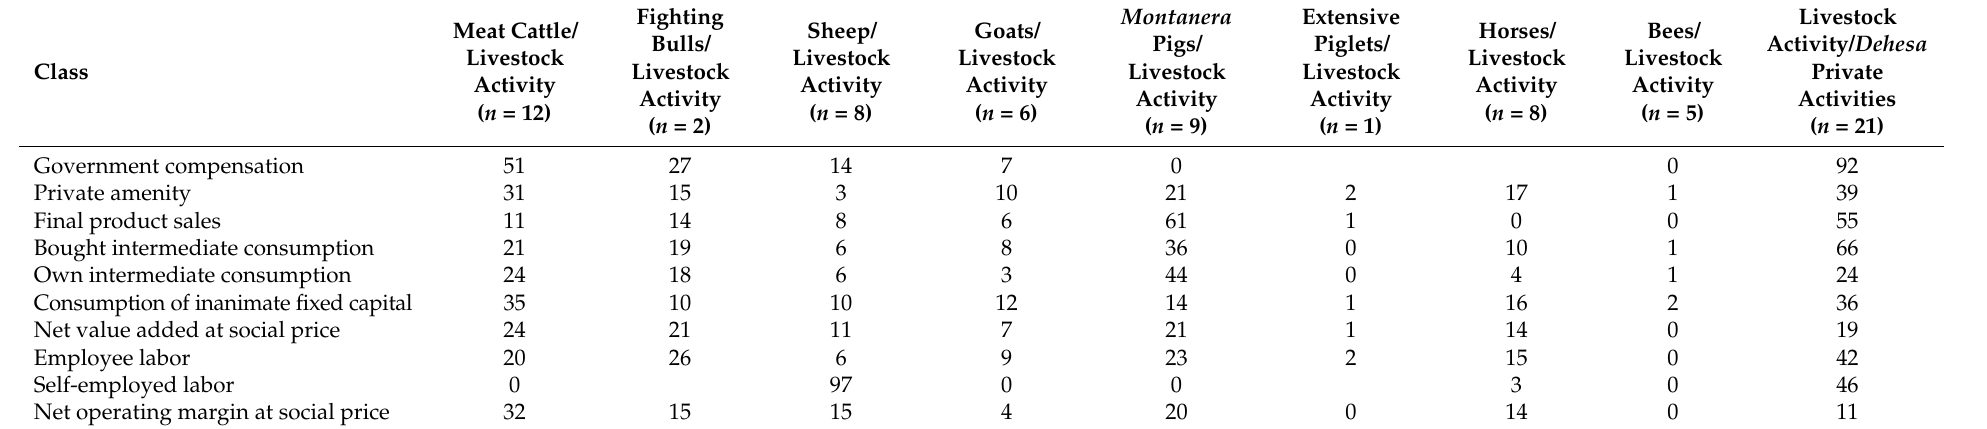
Table 8. Comparison of selected economic indicators for livestock species on large privately owned case-study dehesas in Andalusia (2010: